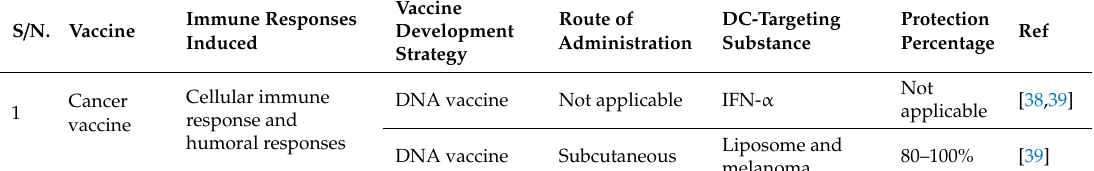
Table 2. Development of vaccine using a dendritic cell (DC)-targeted approach in the selected viruses. S / N.